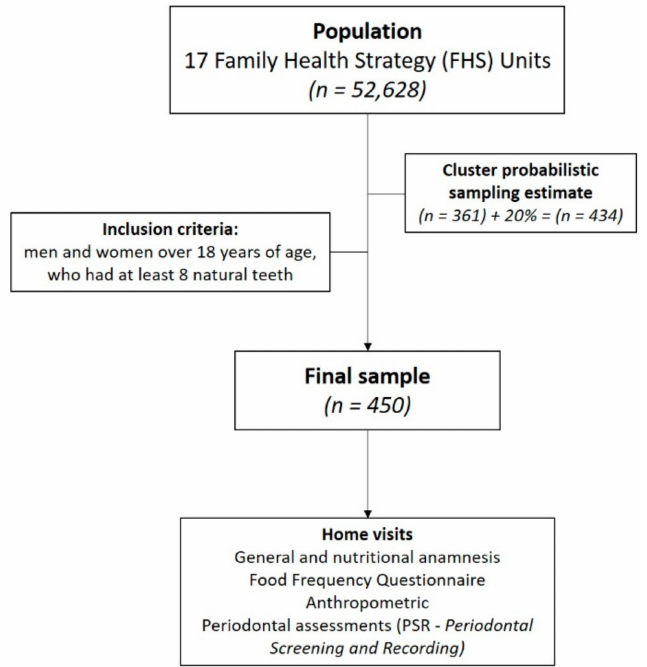
Figure 1. Flowchart of the study design and sample